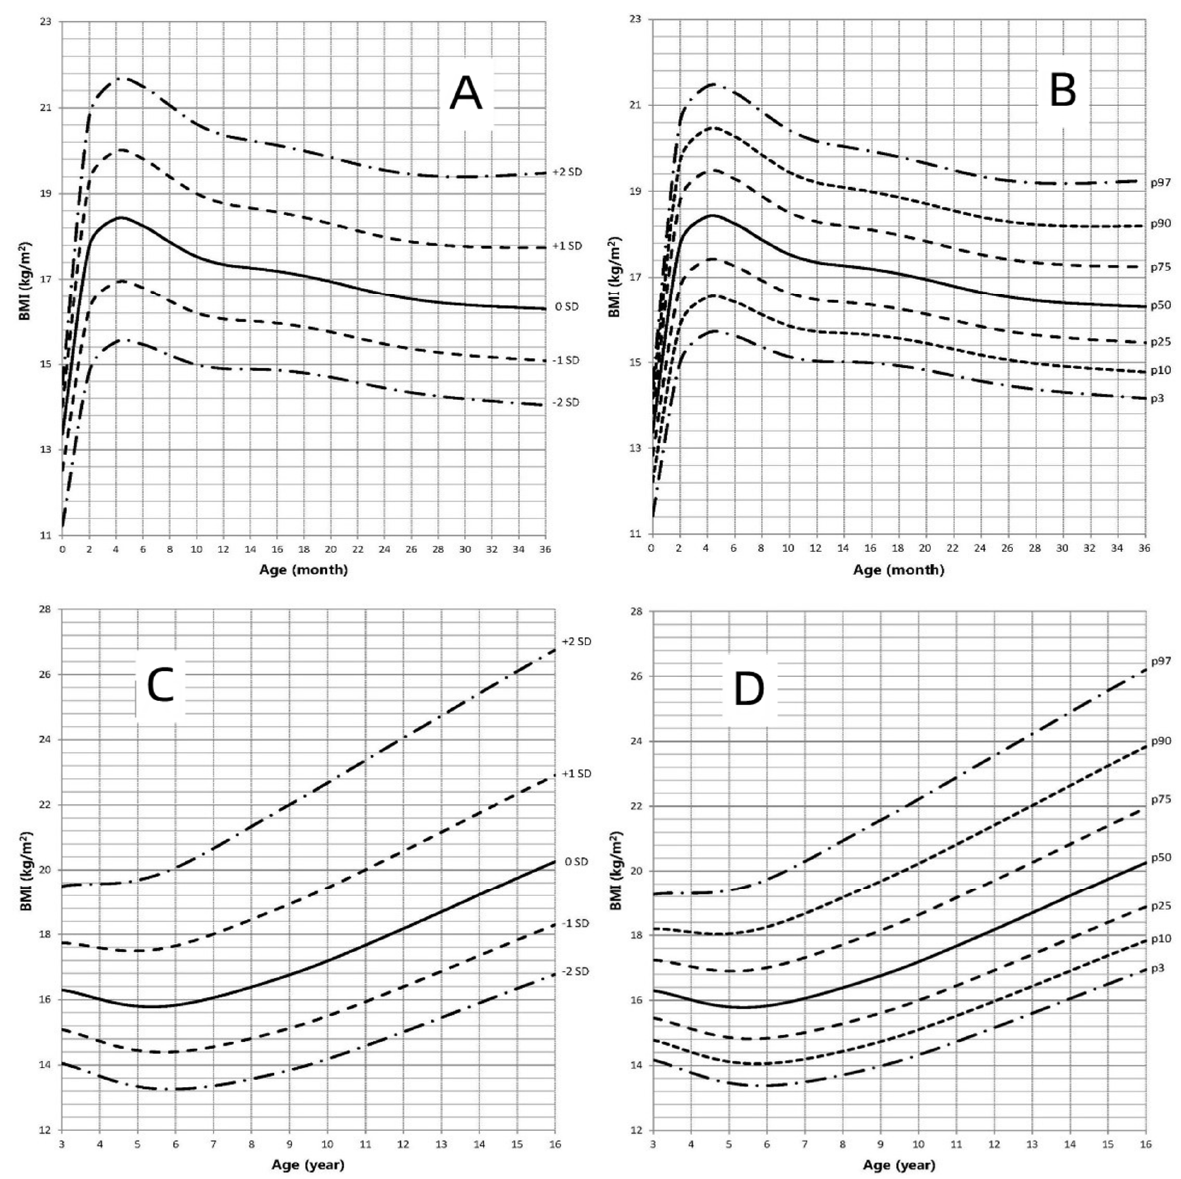
Figure 5. BMI in children with AIS (0–16 years old). ( A ): Standard deviation curve (0–36 months old); ( B ): Percentile curve (0–36 months old); ( C ): Standard deviation curve (3–16 years old); ( D ): Percentile curve (3–16 years old).